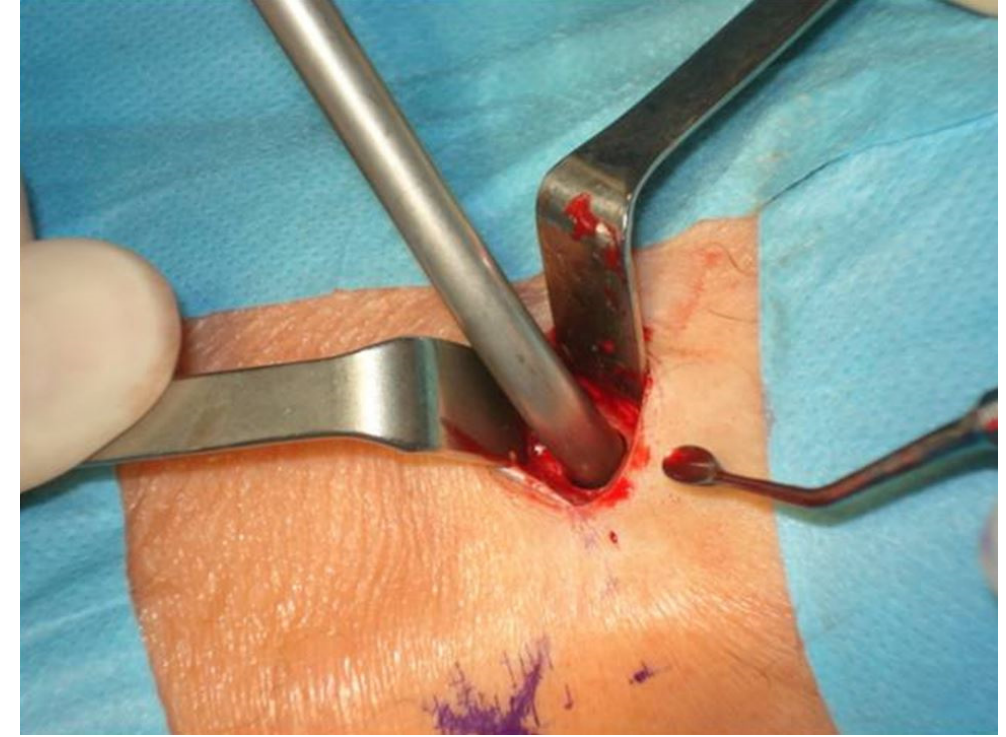
Figure 3. A bone collector attached to the vacuum suction is used to collect the